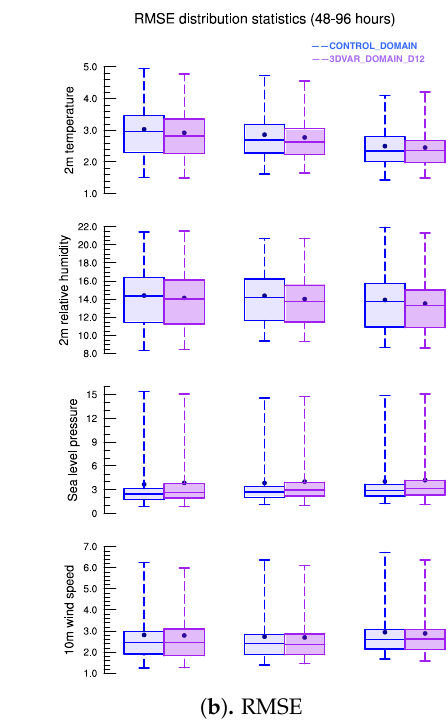
Figure 8. The BIAS station and the RMSE station statistics of 3DVAR_SUMMER (red) comparing to the control case CON- TROL_SUMMER (blue) for the 27 km and 3 km domain. The solid lines represent the mean, the dotted lines represent the median and the shaded areas indicate the upper and lower quartile of the distribution. The statistics of the variables 2 m temperature, 2 m relative humidity, sea level pressure, and 10 m wind speed are shown.